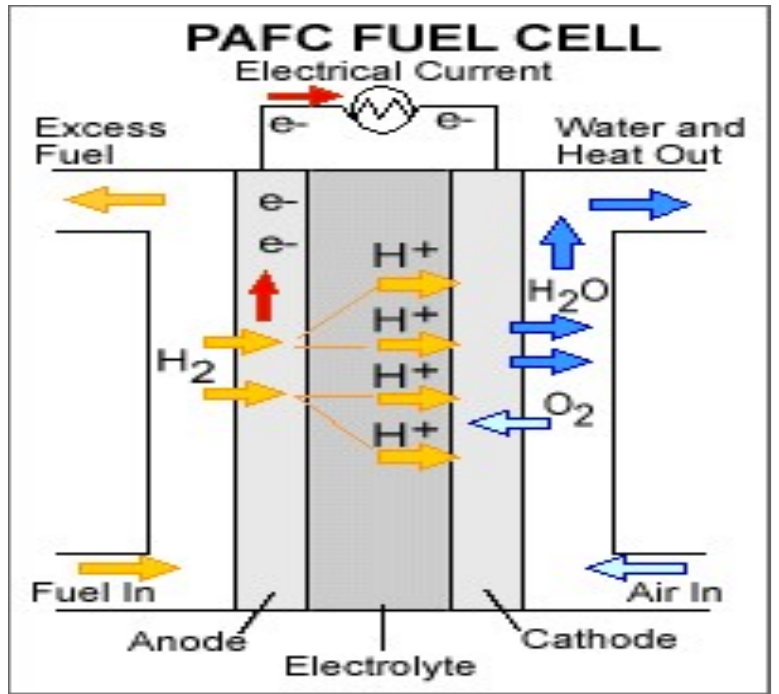
Figure 7. Schematic representation of phosphoric acid fuel cells [41]. Reproduced with permission from Vaghari et al. (2013), ©Springer, 2013 (open access—Creative common attribution